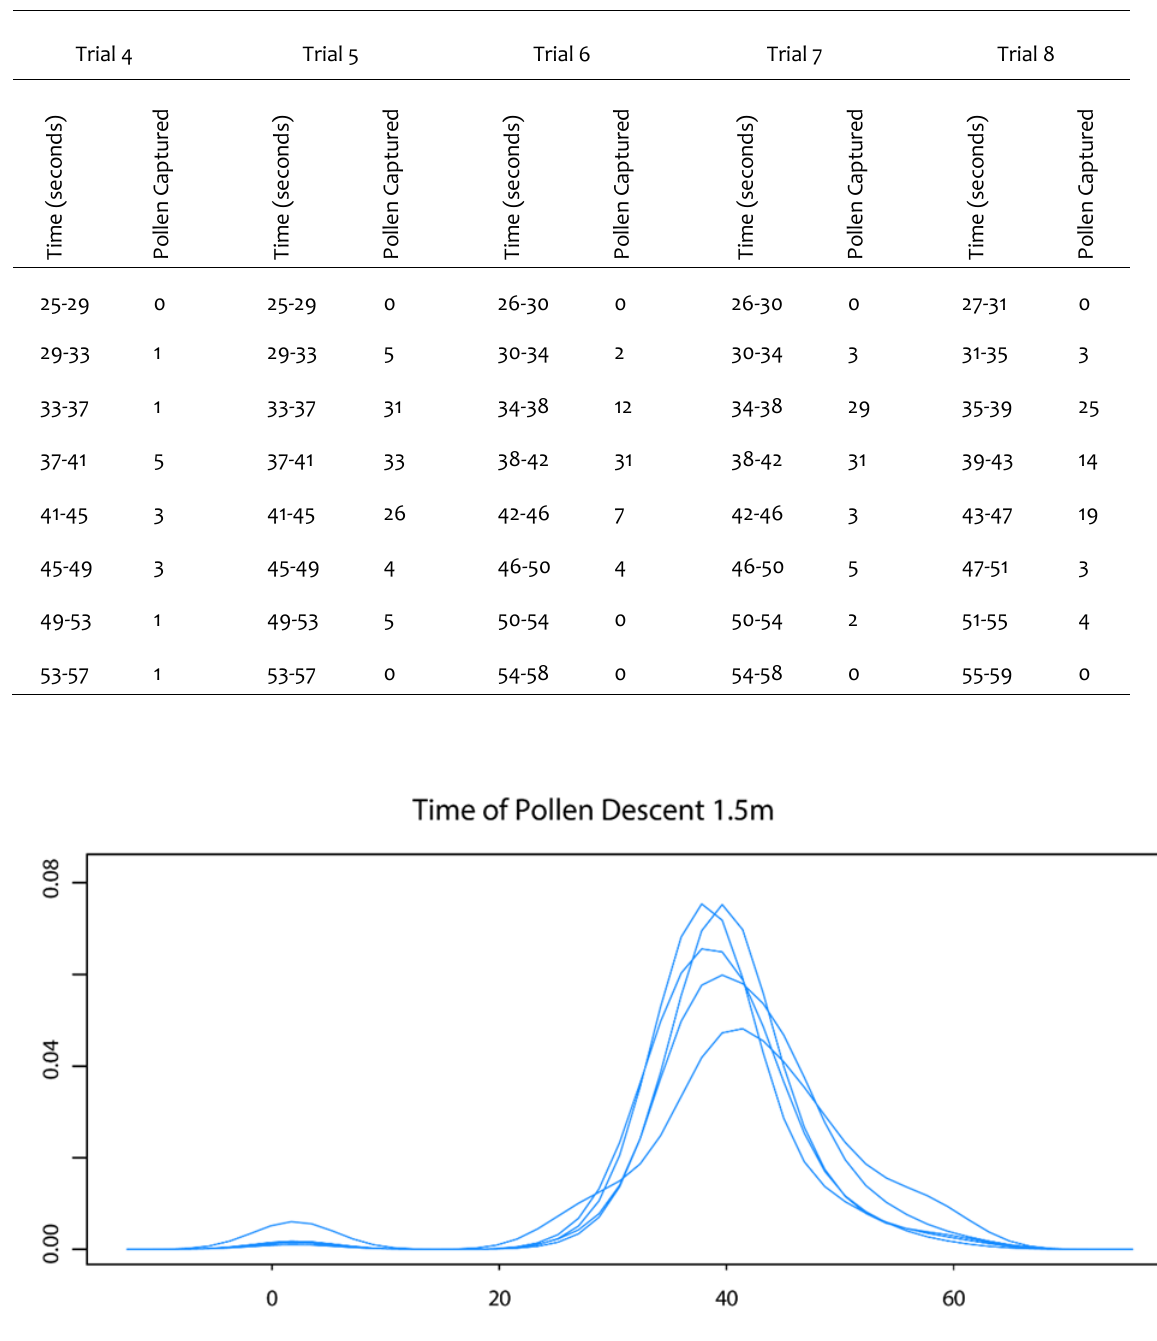
Table 2. Number of D. obovata pollen grains captured at the bottom of 1.5 m drop tower during time intervals after pollen release.